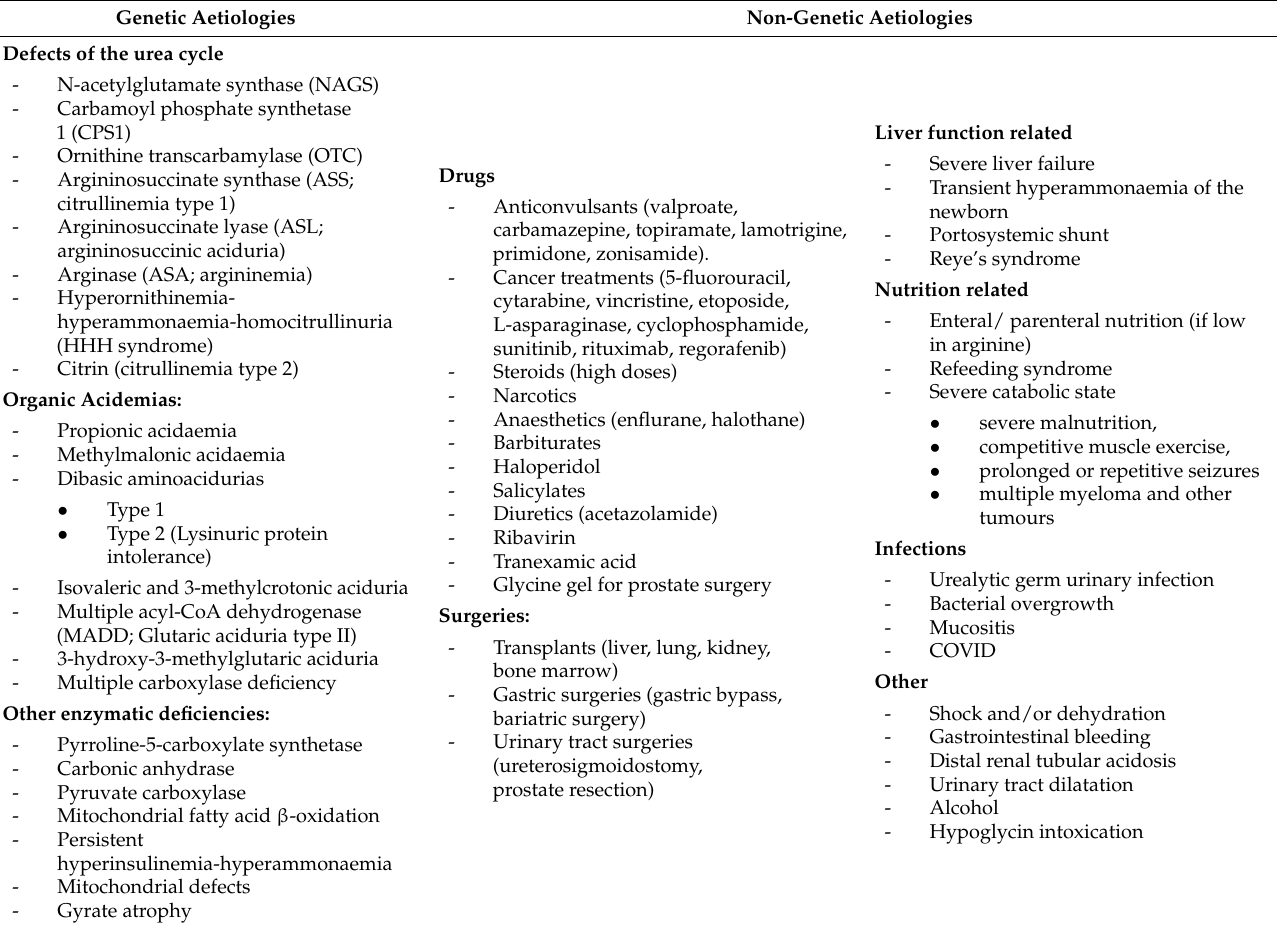
Table 1. Causes of